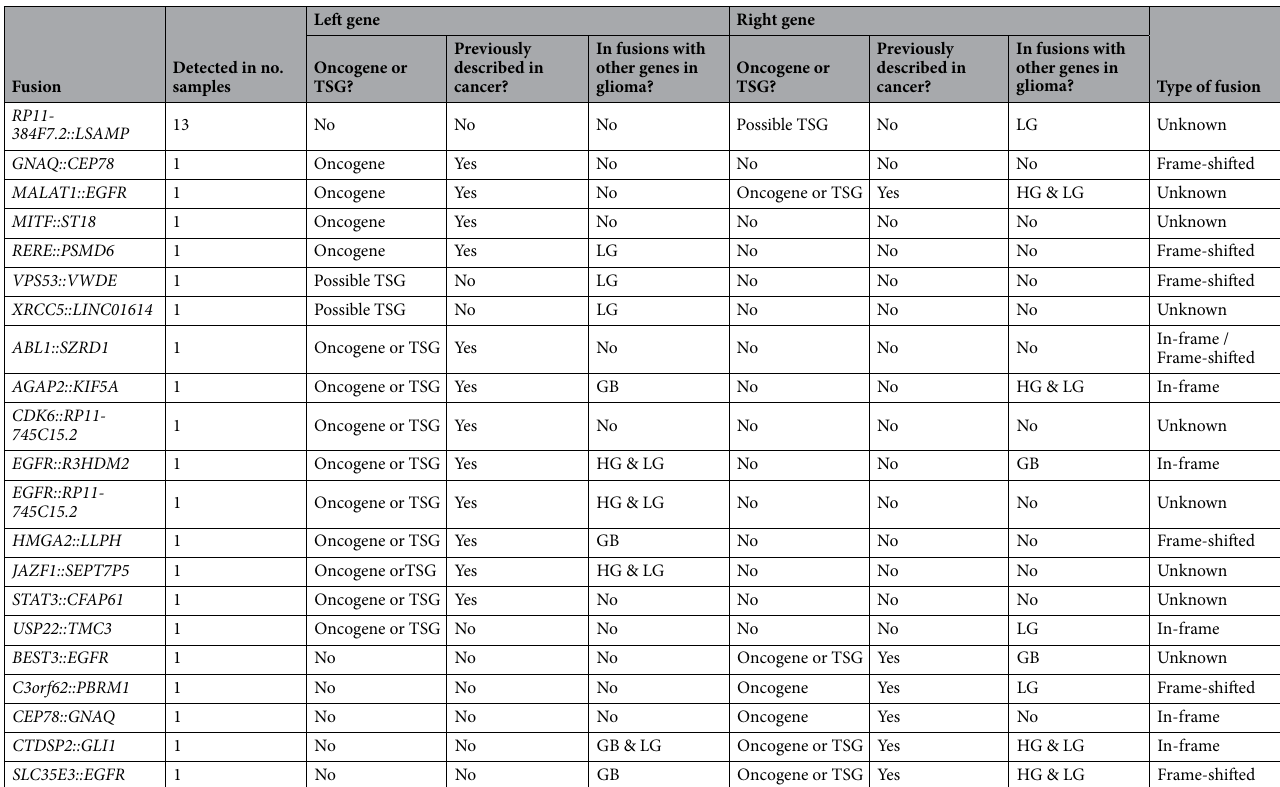
Table 3. Classification of fusions detected in 61 glioblastoma samples: fusions not previously detected in healthy tissue or cancer but involving an oncogene or TSG (N = 21). TSG tumor suppressor gene, LG low-grade glioma, HG high-grade glioma, GB